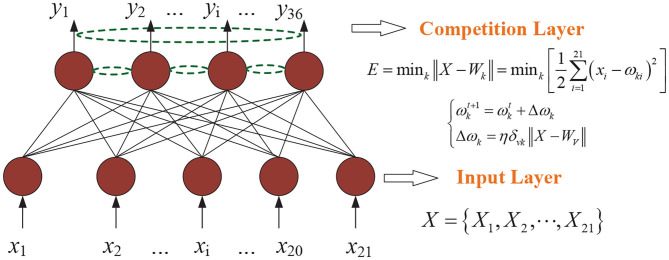
Khonen neural network of 36–21 structure. η is the learning rate. k represents the k-th node of the output layer and ω is regarded as the connection weight value. X stands for the initial vector and i is the i-th node of the input layer.